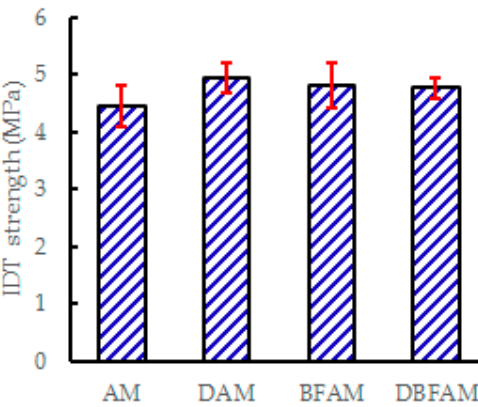
Figure 10. Indirect tensile strength of asphalt mixtures at -10°C.